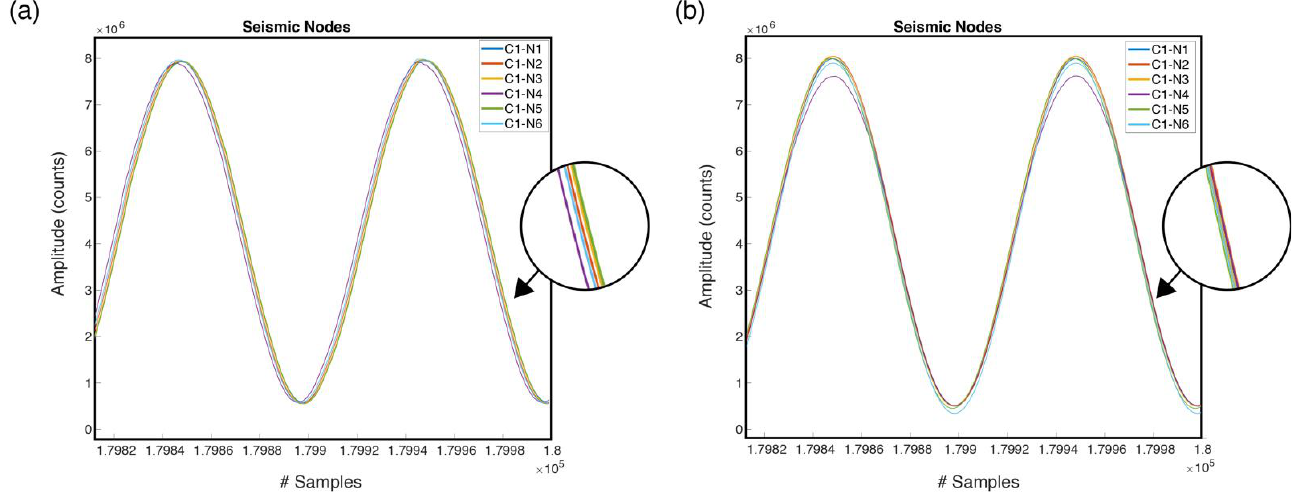
Figure 9. End of a 30 min register with the data obtained for the 6 nodes: ( a ) with Timer_A0 configured with the default value. ( b ) with Timer_A0 configured with the calibrated value.